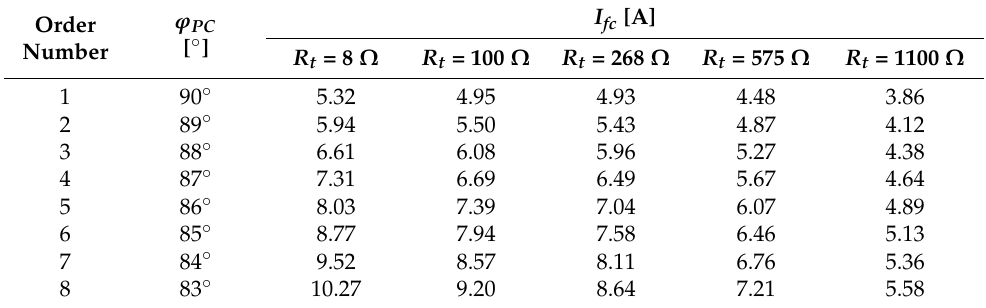
Table 5. Effective value of the fault current depending on ϕ PC , when ϕ c = 85.3 ◦ (experimentally determined angle value ϕ c in the real network 20 kV).